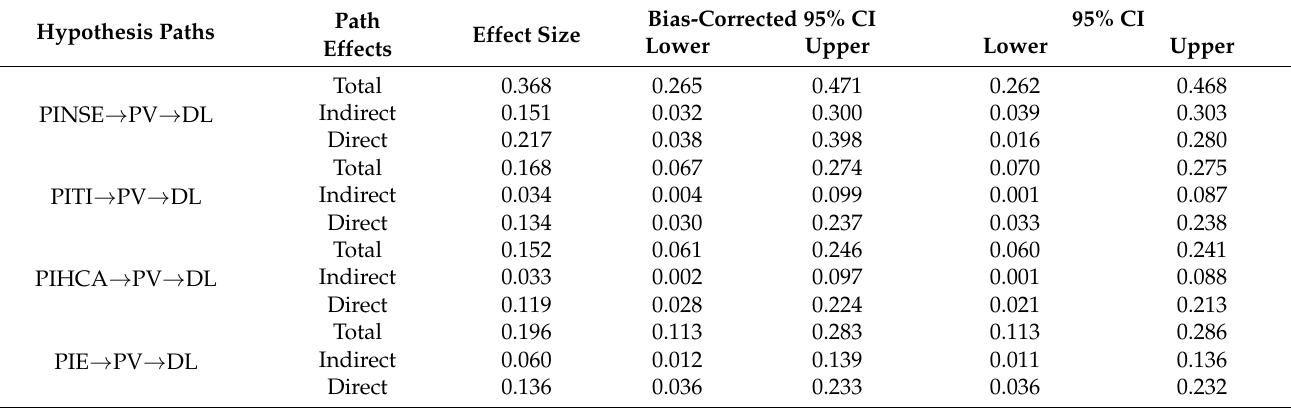
Table 5. Results of the analysis of mediation effects.